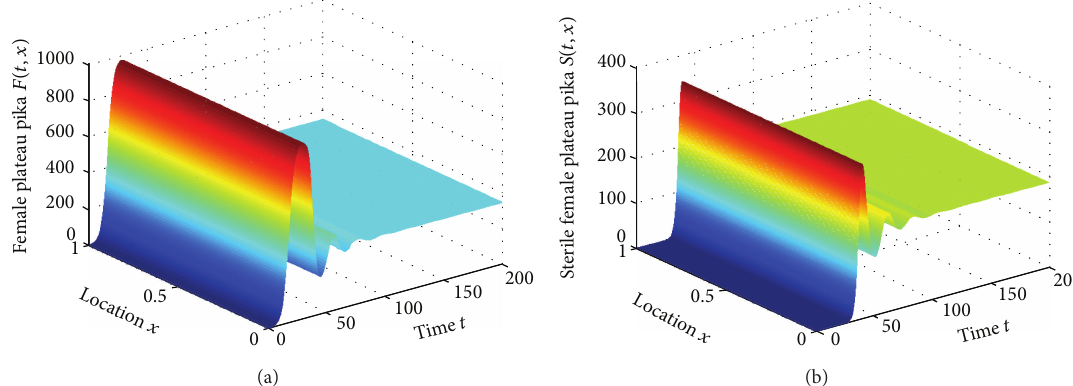
Figure 1: Plateau pika coexistence steady state 𝑤 ∗ with initial conditions 𝐹(𝑥,0) = 𝐹 0 (𝑥) = 1 , 𝑆(𝑥, 0) = 𝑆 0 (𝑥) = 0.5 .